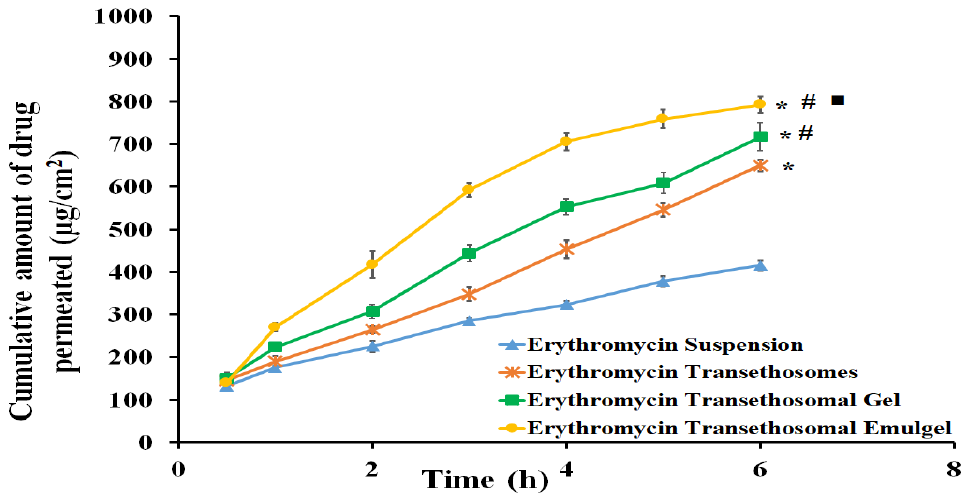
Figure 6. Permeation study of erythromycin from different formulations compared to erythromycin suspension (control). Results are represented as mean ± SD (n = 3). * compared to Erythromycin suspension ( p < 0.05); # compared to erythromycin transethosomes ( p < 0.05); and ■ compared to erythromycin transethosomal gel ( p < 0.05).